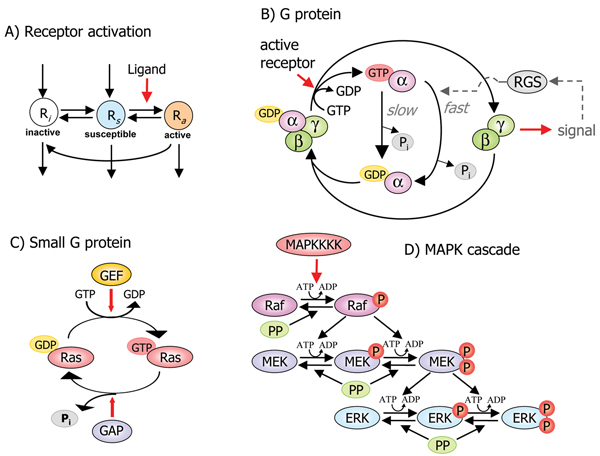
Building blocks. Building blocks or modules of signaling pathways. Despite their diversity, signaling pathways often employ a set of common components (modules, motifs, building blocks) including the depicted ones. A) Receptors sense specific ligands or stimuli and change their conformation from the susceptible form Rs to the active form Ra, which transfers the signal downstream. Cells can fine-tune their excitability by (i) changing the susceptibility of receptors, e.g. switch between Rs and inactive form Ri, or (ii) by regulating the number of receptors via production or internalization and degradation. B) G proteins are heterotrimers consisting of subunits α, β, and γ. In the ground state, the α-subunit is bound to GDP. The active receptor triggers the activation of the G protein by exchanging the GDP with a GTP. The G protein dissociates into its subunits, which transmit the signal downstream by binding to other proteins and activating or inhibiting biochemical processes. The α-subunit carries the GTP. After GTP hydrolysis, which is a highly regulated process on its own, the subunits can reassociate to form the initial heterotrimeric G protein. The Regulator of G protein signaling (RGS) is involved in a larger feedback loop. C) Small G proteins switch between GDP-bound or GTP-bound forms with different activities. Conversion from the GDP state to the GTP state is catalyzed by a so-called Guanine Exchange Factor (GEF), the reverse process is facilitated by a GTPase-activation protein (GAP), which induces hydrolysis of the bound GTP [13]. D) MAPK (mitogen activated kinase) cascades consist of three or four different proteins (the kinases) that specifically catalyze the phosphorylation of the subsequent kinases under consumption of ATP. In this case, Raf is a MAPKKK, MEK is a MAPKK, and ERK is a MAPK. The number of phosphorylation events on each level can differ. Dephosphorylation is exerted by phosphatases (denoted by PP).